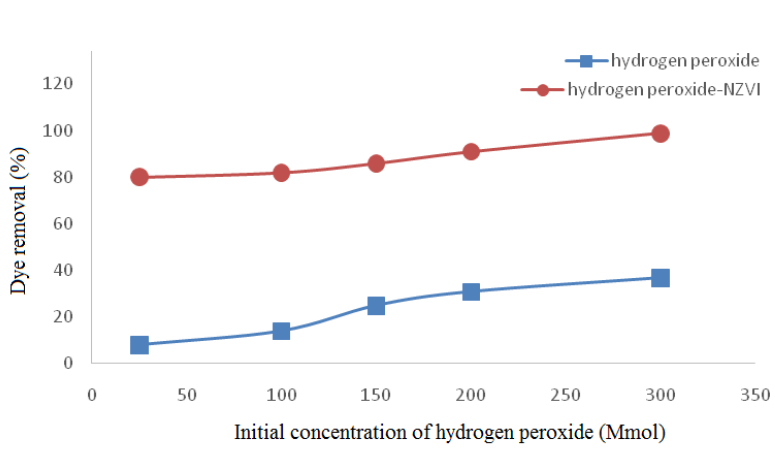
Fig 8. Effect of initial concentration of hydrogen peroxide on process efficiency. (Contact time: 40 min, pH=4, initial dye concentration of 75 mg/L, concentration of iron nanoparticles: 2